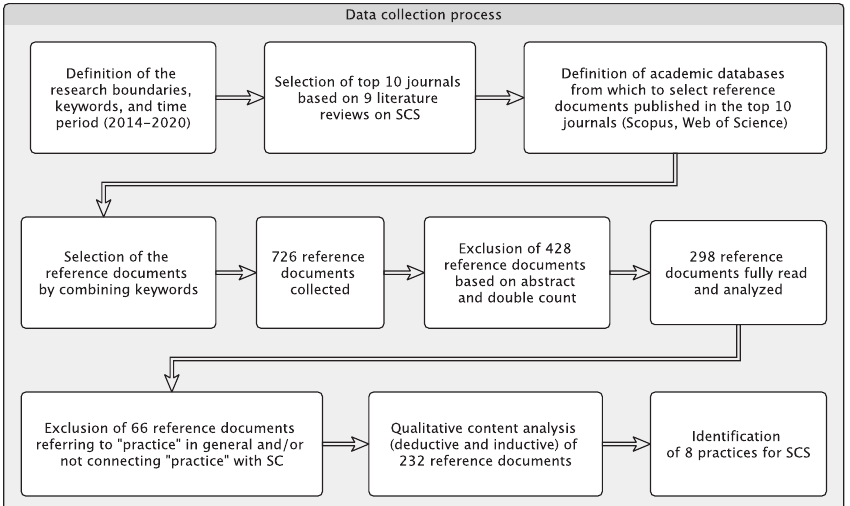
Figure 1. Structured